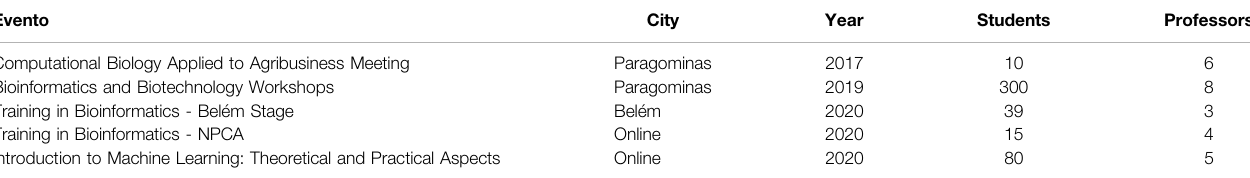
TABLE 1 | List of events held in the context of the “ Bioinformatics on the Road ” project with information on the place where it took place, year and total number of students and teachers.